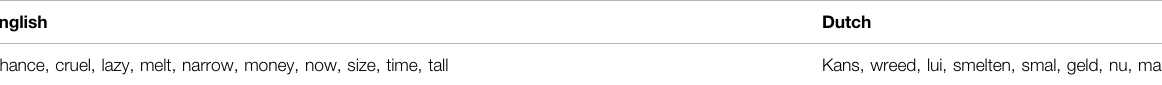
TABLE 2 | Ten English and Dutch low-association words used in the association task. English Dutch Chance, cruel, lazy, melt, narrow, money, now, size, time,